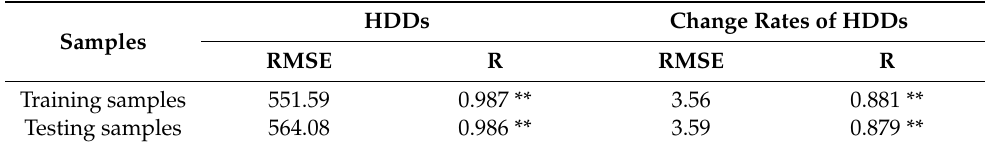
Table 1. Simulation accuracy of heating degree days (HDDs) and their interannual change rates based on the generalized regression neural network